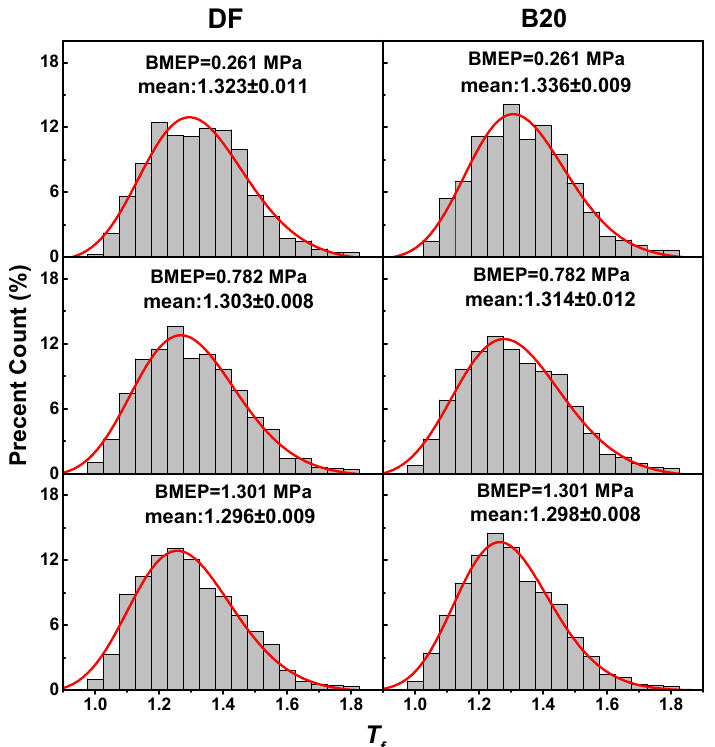
Figure 7. Histograms of tortuosity (T f ) for both DF and B20 soot in the applied test modes .